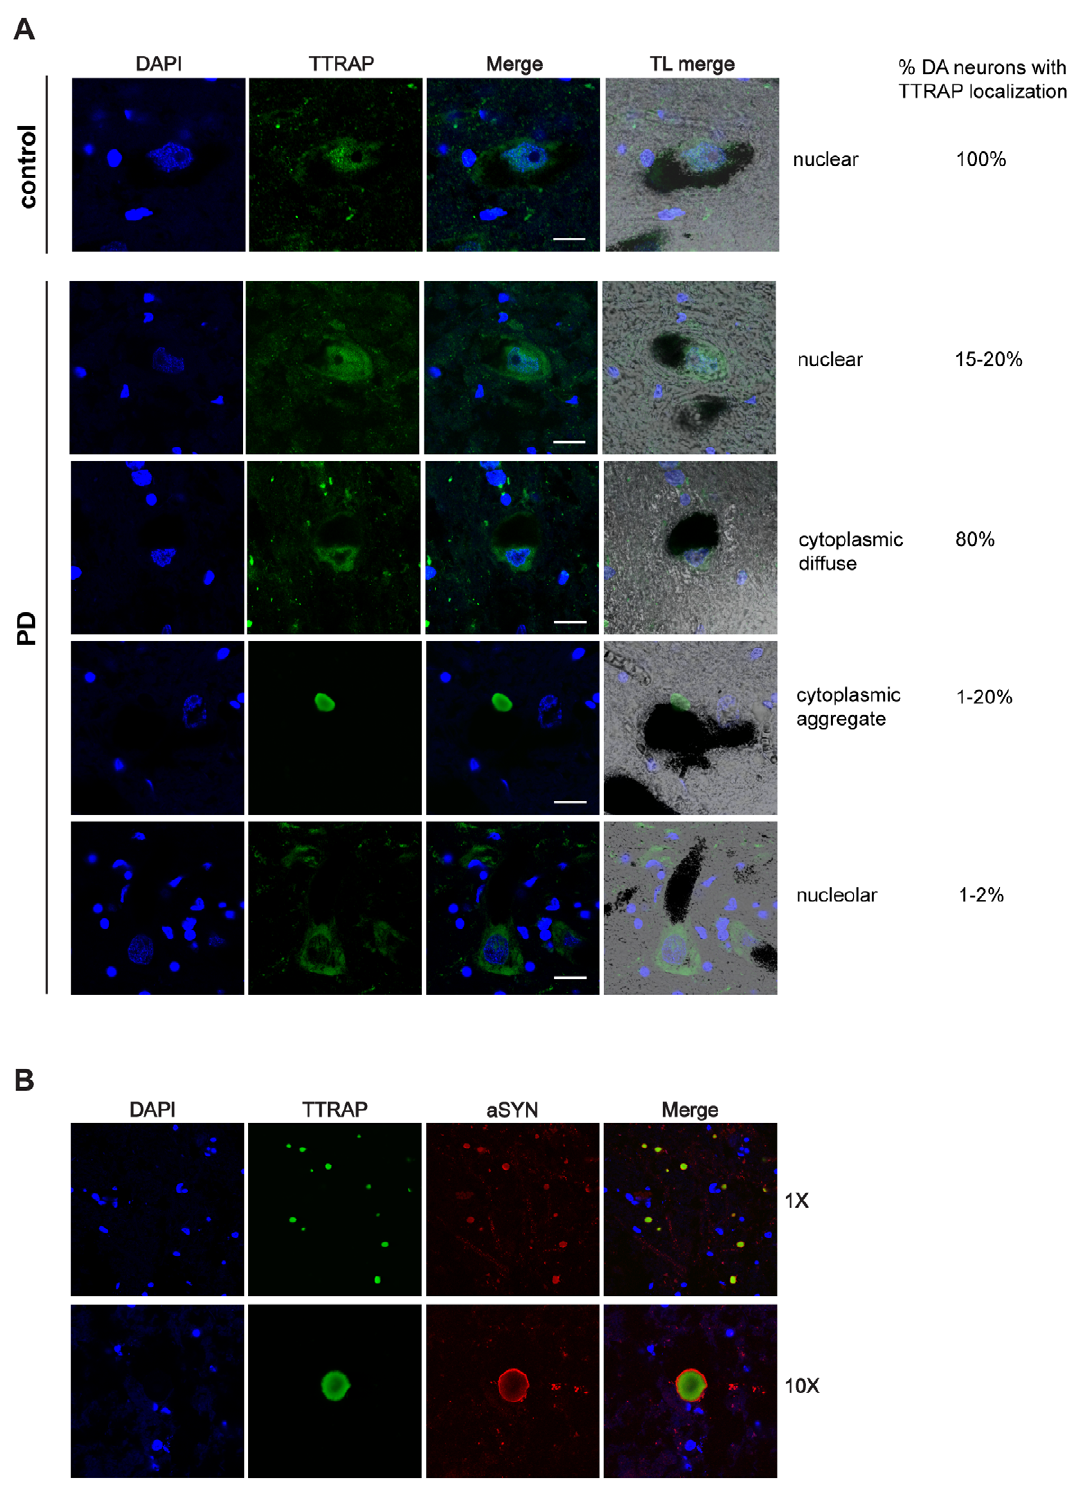
Figure 1. TTRAP is present in cytoplasmic Lewy bodies and in the nucleolus in surviving dopaminergic neurons in PD post-mortem brains. (A) TTRAP localization in normal and PD dopaminergic neurons. Cryo-sections of post-mortem brain tissues were taken from Substantia Nigra of healthy individuals and PD patients, as indicated. Immunohistochemistry was performed with anti-TTRAP antibody (green). Nuclei were stained with DAPI (blue). Dopaminergic neurons were identified by neuromelanin (black) in transmitted light (TL). Overlays of fluorescence (merge) and fluorescence with TL (TL merge) are shown. Panels are representative images showing TTRAP nuclear, cytoplasmic diffused, cytoplasmic aggregated and nucleolar localization. The percentage of dopaminergic neurons with nuclear, cytoplasmic or nucleolar TTRAP staining is indicated on the right. Bars, 15 m M. (B) TTRAP-containing cytoplasmic aggregates are Lewy bodies. Immunohistochemistry of Substantia Nigra from PD brains was performed with anti-TTRAP (green) and anti-alpha-synuclein (red) antibodies. Images at low (1 6 ) and high (10 6 ) magnification are shown. doi:10.1371/journal.pone.0035051.g001 PLoS ONE |